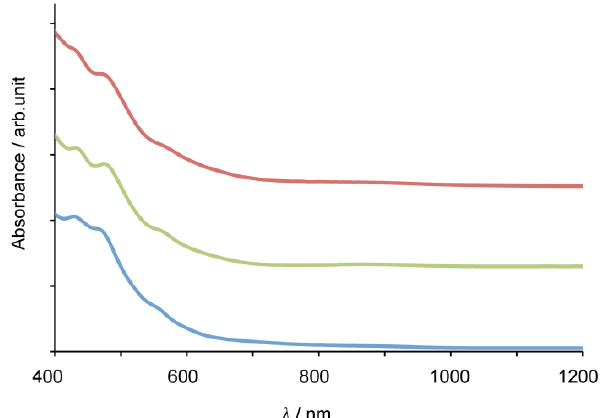
Figure 4. Vis/NIR absorption spectra of 9 (red), La (blue) in CS